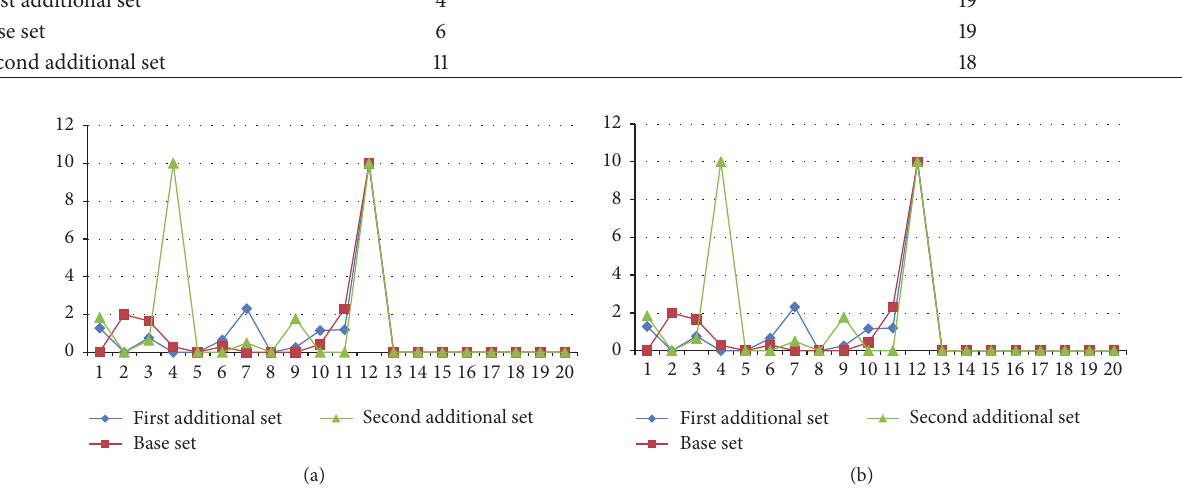
Figure 3: Solving time (seconds) of the instances of the group III by (a) the CPLEX Solver and (b) the branch and bound algorithm.